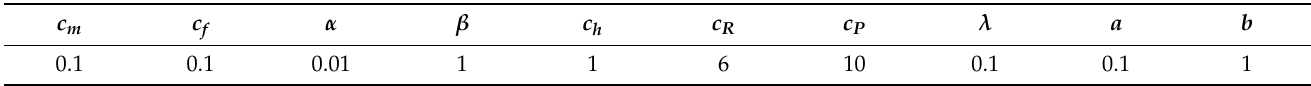
Table 1. Parameter values.